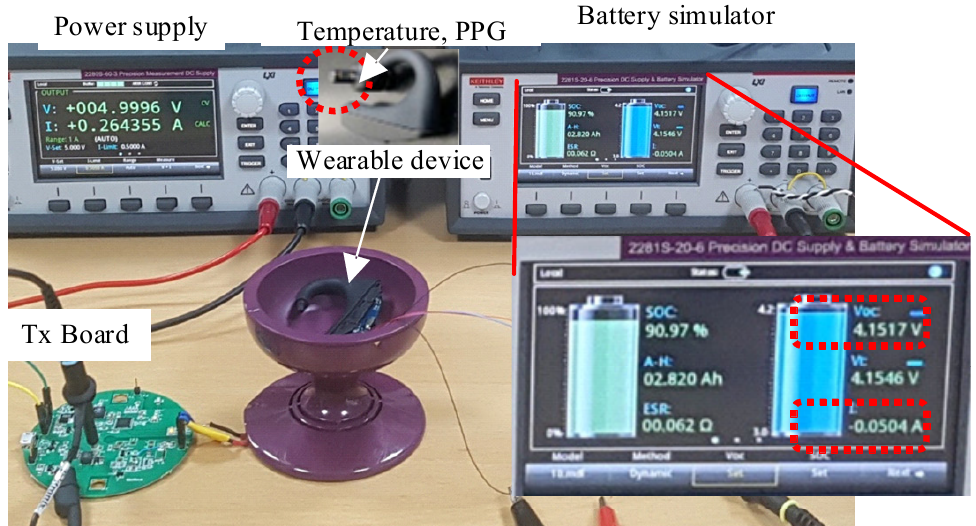
Figure 19. The experimental setup for the wireless power transfer system for a wearable bio-signal monitoring device.